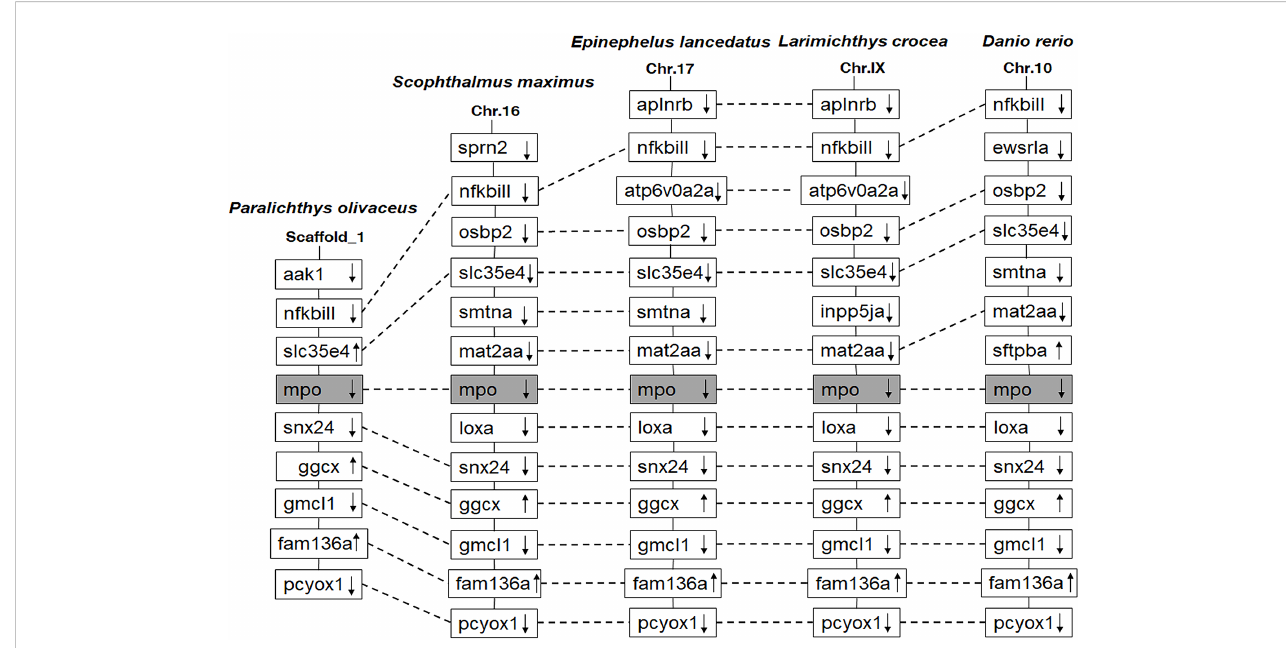
FIGURE 2 Comparison of the location of MPO genes in different fi sh species. The chromosomes and scaffold were identi fi ed in NCBI. Boxes represent the deduced genes. Arrows indicate the deduced orientation of gene transcription. Dashed lines connecting boxes suggest a homologous